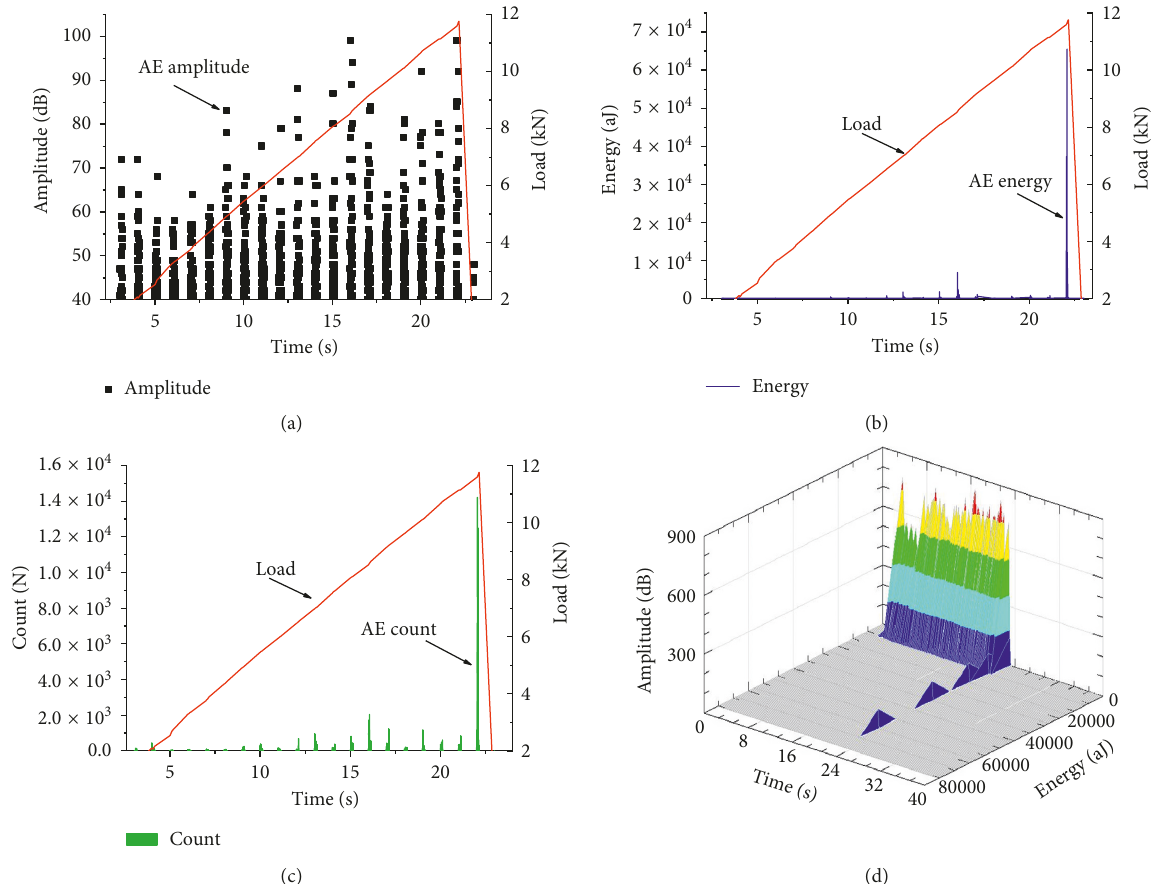
Figure 8: AE characteristics of the basalt columnar joints under dry state: (a) AE amplitude and time, (b) AE energy and time, (c) AE count and time, and (d) AE amplitude, energy, and time.